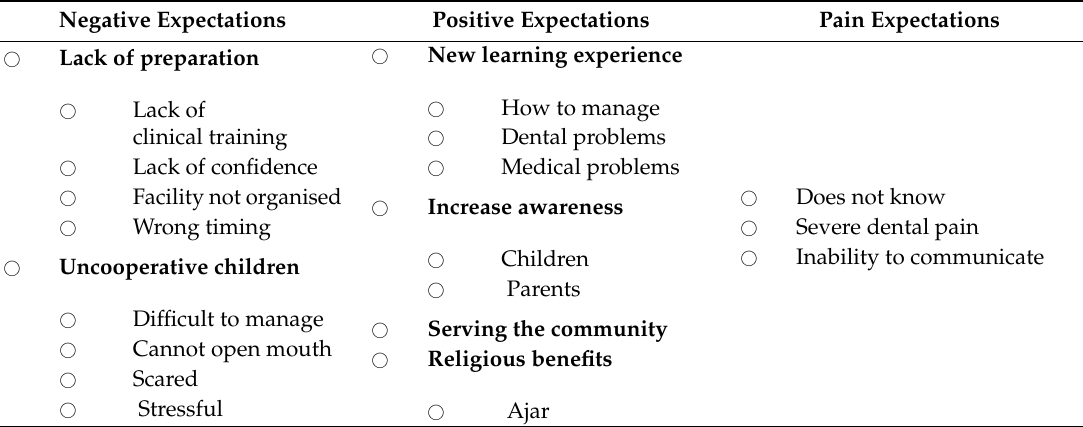
Table 3. Coding tree of student perceptions before the fieldwork visit showing the three main themes, their subthemes (bold), and elements (bullet